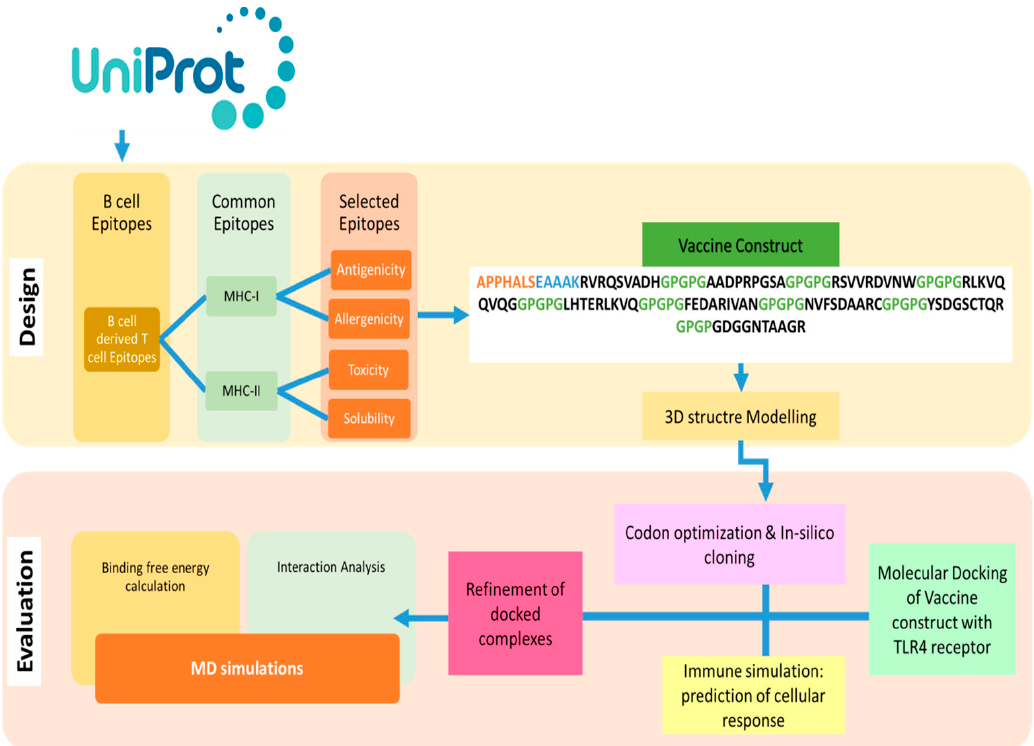
Figure 1. Outline of methodology followed in this study to find B and T cell epitopes and designed MEVs using immunoinformatics methods is shown in the flow chart above. Additionally, biophys- ical investigation was carried out using integrated docking, modeling, and binding free energies